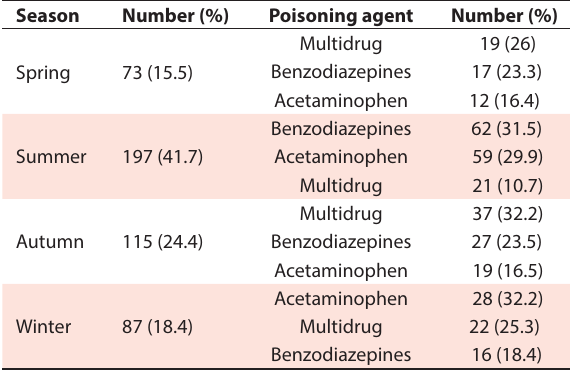
Table 2. Distribution of poisoning agent in different